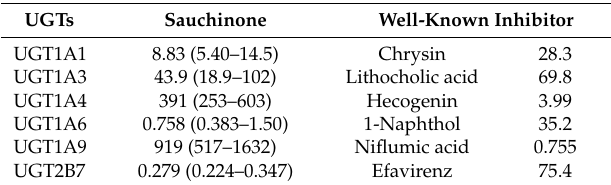
Table 1. IC 50 ( µ M) values of sauchinone ( n = 3 for each UGT isoform) and well-known inhibitors ( n = 1 for each UGT isoform) for inhibition of various UGTs in human liver microsomes. Data were expressed as the mean values. The minimum and maximum values of IC 50 were expressed in the parentheses.